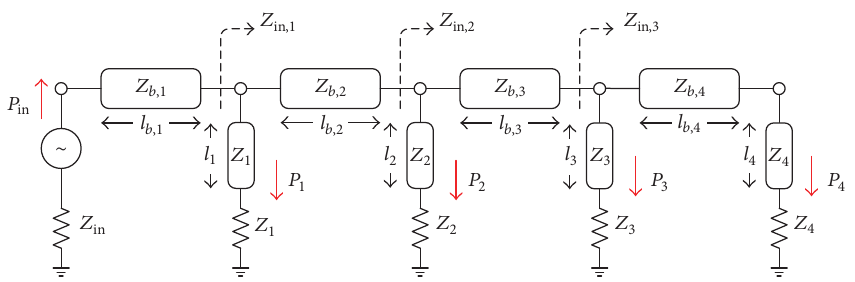
Figure 1: Equivalent circuit of the series power